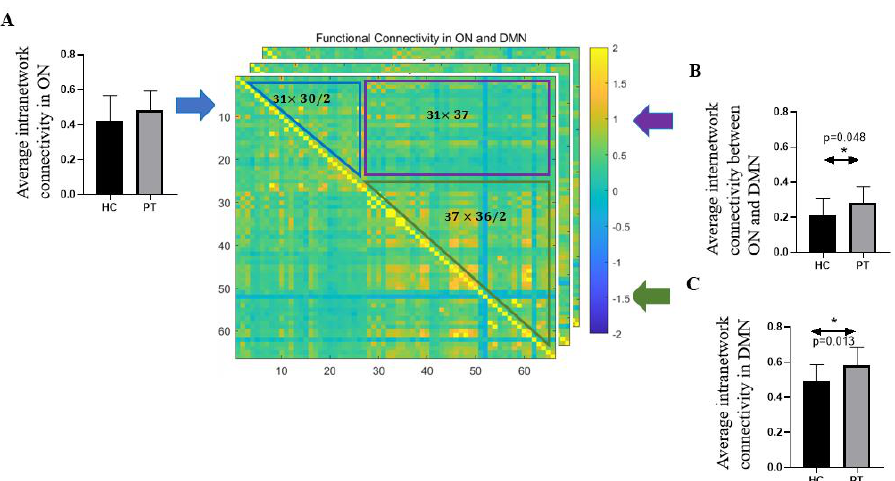
Figure 4. Schematic representation of the comparison of average intra- and inter-network connectivity in ON and DMN between COVID patients and healthy adults. Each subject has a 68 × 68 functional connectivity matrix. The values in the blue triangle indicate the correlation coefficients between pairs of the 31 regions within the ON, and in the green triangle represent the functional connectivity between the corresponding regions in DMN (37 regions). Voxels in the purple rectangle illustrate the functional connections between regions in ON and regions in DMN. In healthy control and patients, the comparison of ( A ) average intranetwork connectivity in ON; ( B ) average internetwork connectivity between ON and DMN and ( C ) average intranetwork connectivity in DMN. (Error bar shows the standard deviation of measurements, * indicates that p < 0.05.)